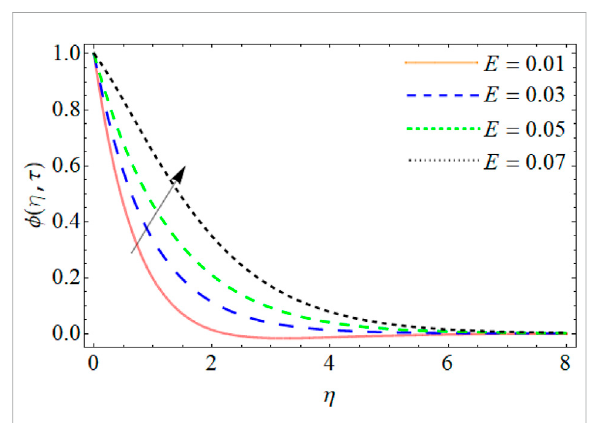
FIGURE 13 Mass outlines ϕ ( η , τ ) versus constructive chemical reaction γ .